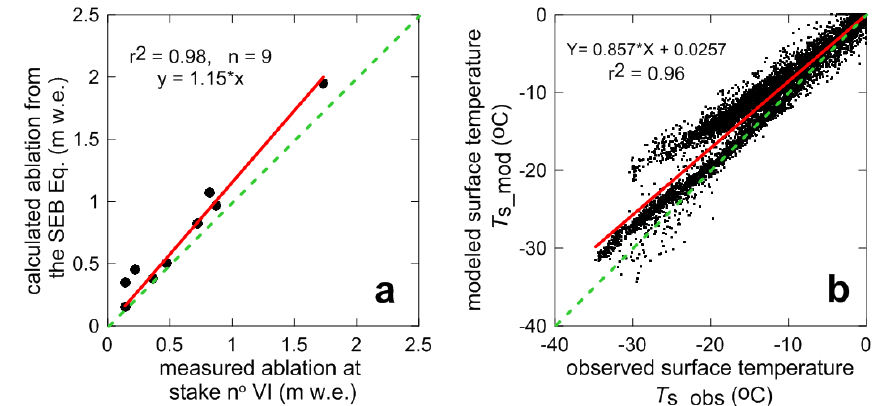
Figure 11. Comparison between ablation computed from the SEB equation and measured at stake no. VI (a) during several few-day to few- week periods of 2012 and 2013 summers where field measurements are available. (b) Comparison between modelled half-hourly ( T s_mod ) and observed ( T s_obs ) surface temperatures over the whole simulation period. Also shown are the 1:1 line (dashed line) and the regression line (solid